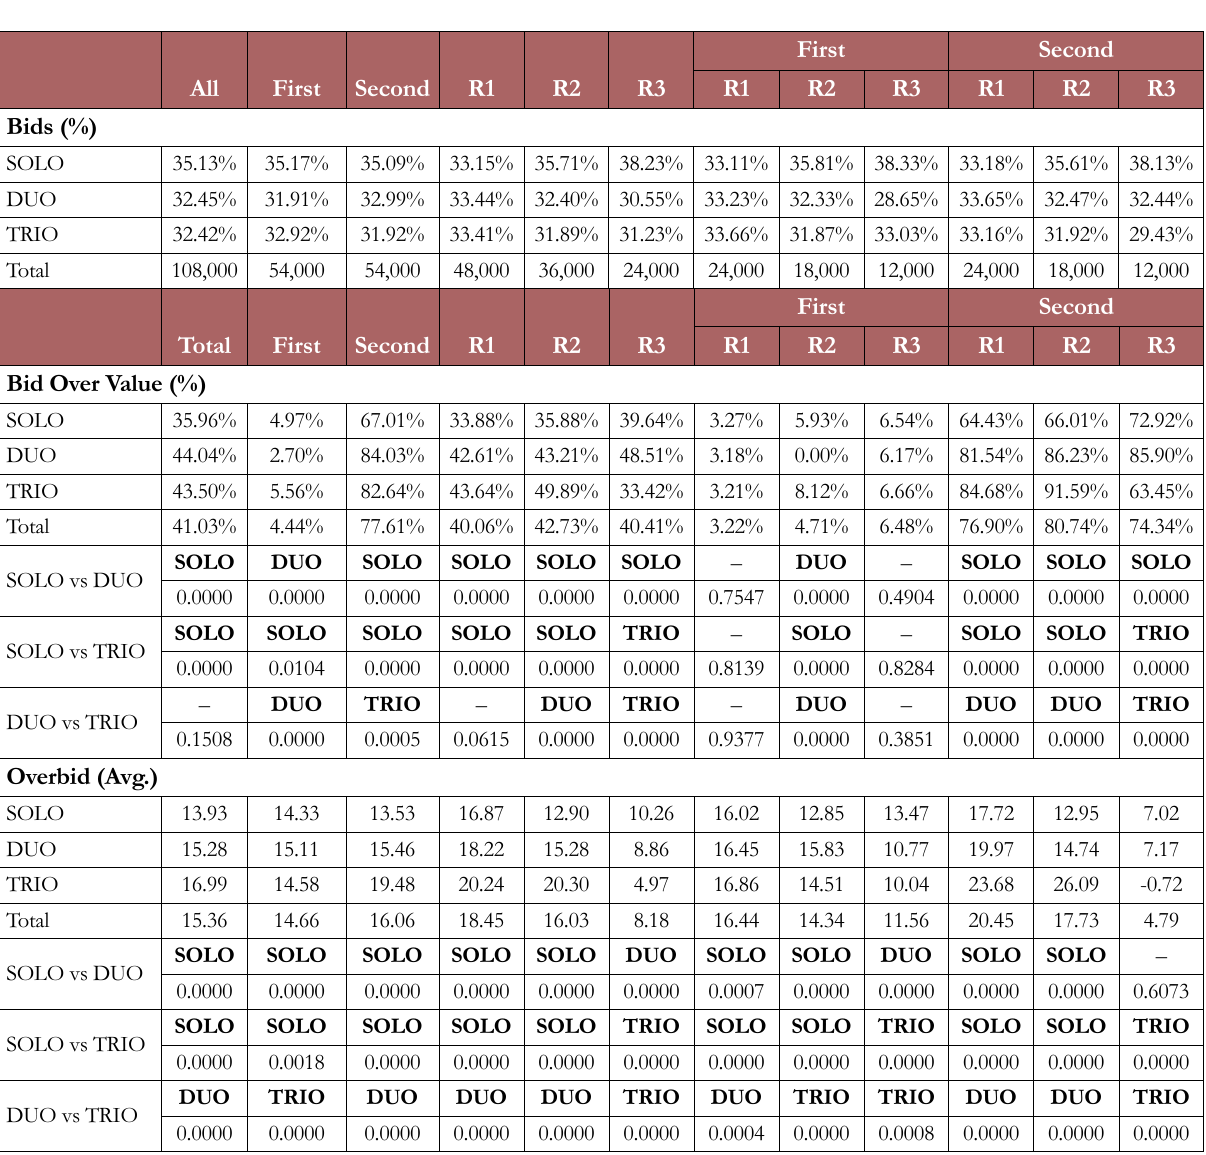
Table AII.3. Virtual professionals’ and the bidding behavior: pairwise differences in terms of size by right and mechanism